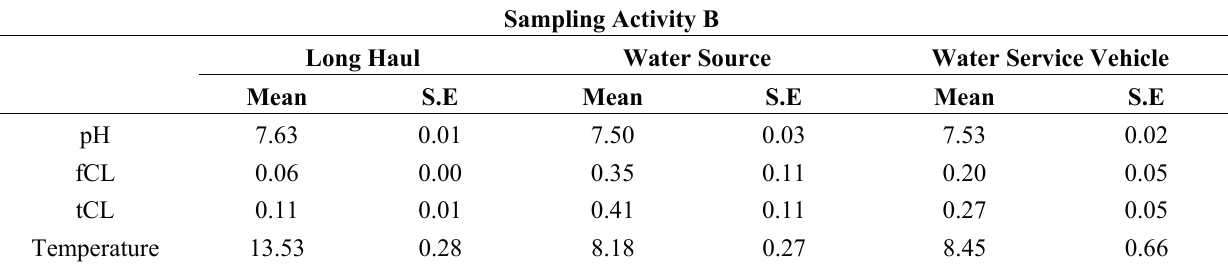
Table 5. Physical and Chemical Analysis for Sampling Activity B across the Long-Haul aircraft, the Water Source and the Water Service Vehicle.